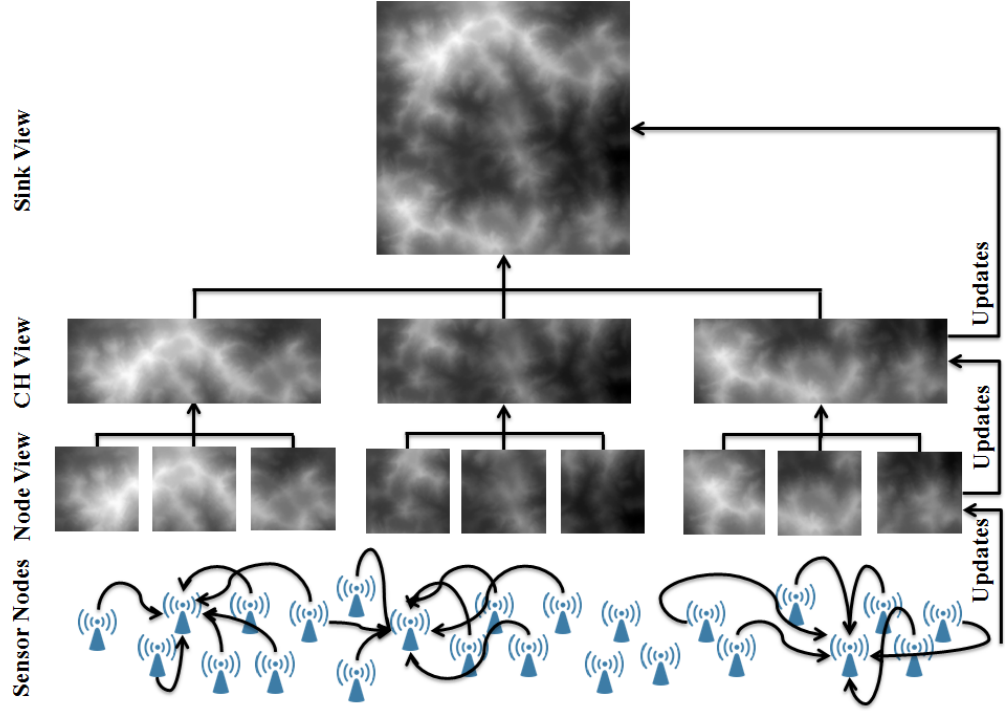
Figure 2. An illustrative diagram showing a generic WSN and how the distributed mapping service operates on